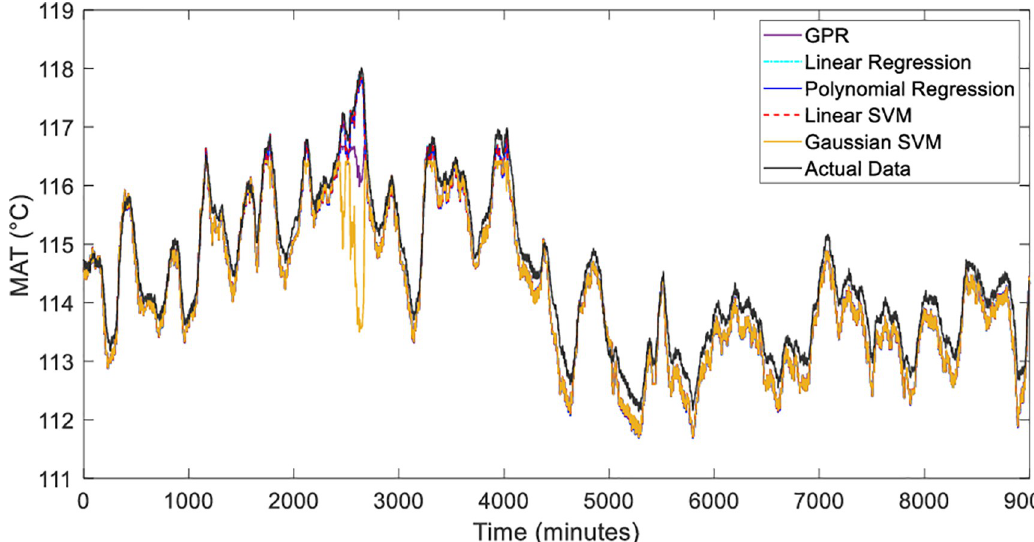
Fig 9. T h response of five estimation methods without zooming.